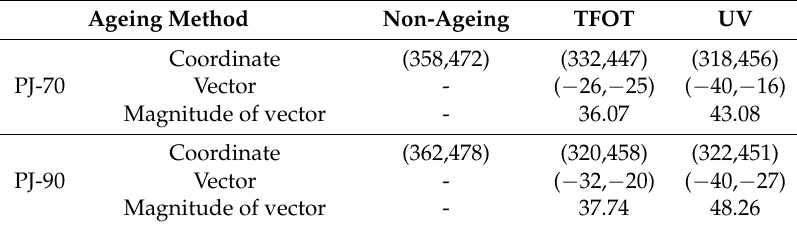
Table 2. Parametrization of peak